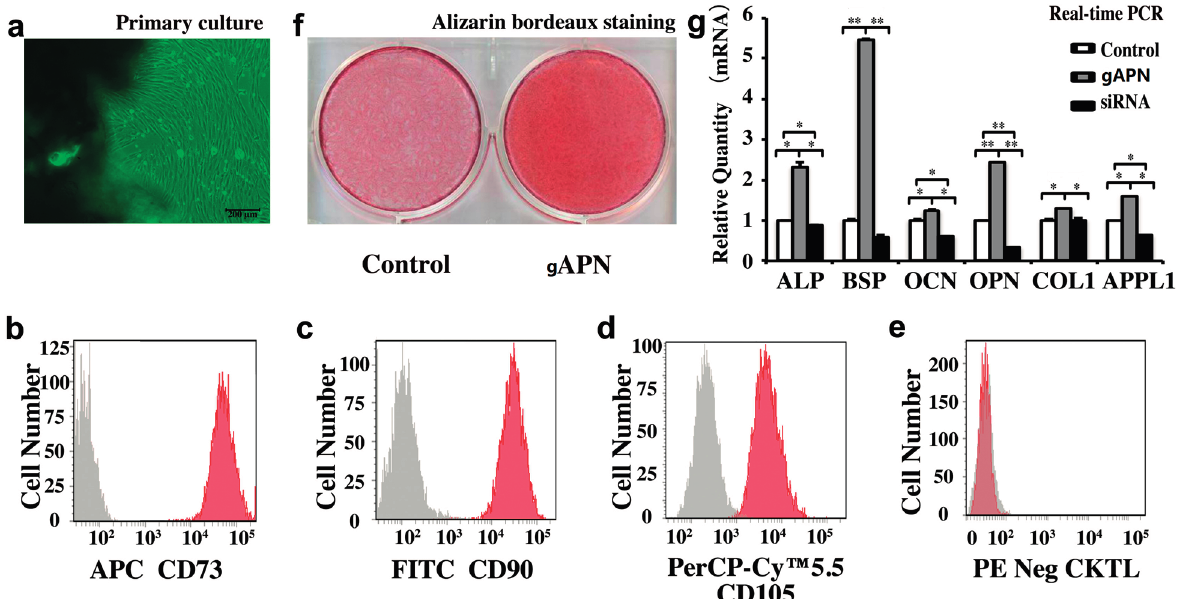
Figure 7. gAPN promoted the osteogenic commitment of h-JBMMSCs to favour osteoblastic differentiation. ( a ) The primary cultures were explanted from human granulation tissue in the 3rd molar extraction socket; ( b – e ) The primary cultured h-JBMMSCs were identified by flow cytometry. The h-JBMMSCs were positive for CD73, CD90, and CD105, but were negative for CD34, CD11b, CD19, CD45, and HLA-DR (red). All the results were with h-JBMMSC (red) and isotype control (light gray); ( f ) h-JBMMSCs were treated with vehicle and gAPN in osteogenesis induction medium for 21 days, followed by ascorbic acid staining; ( g ) Changes in gene expression of h-JBMMSCs following 24 h of gAPN treatment analysed using quantitative RT-PCR. Data are shown as the mean ± SD, with n = 4. * p < 0.05, ** p < 0.01 as determined by one-way